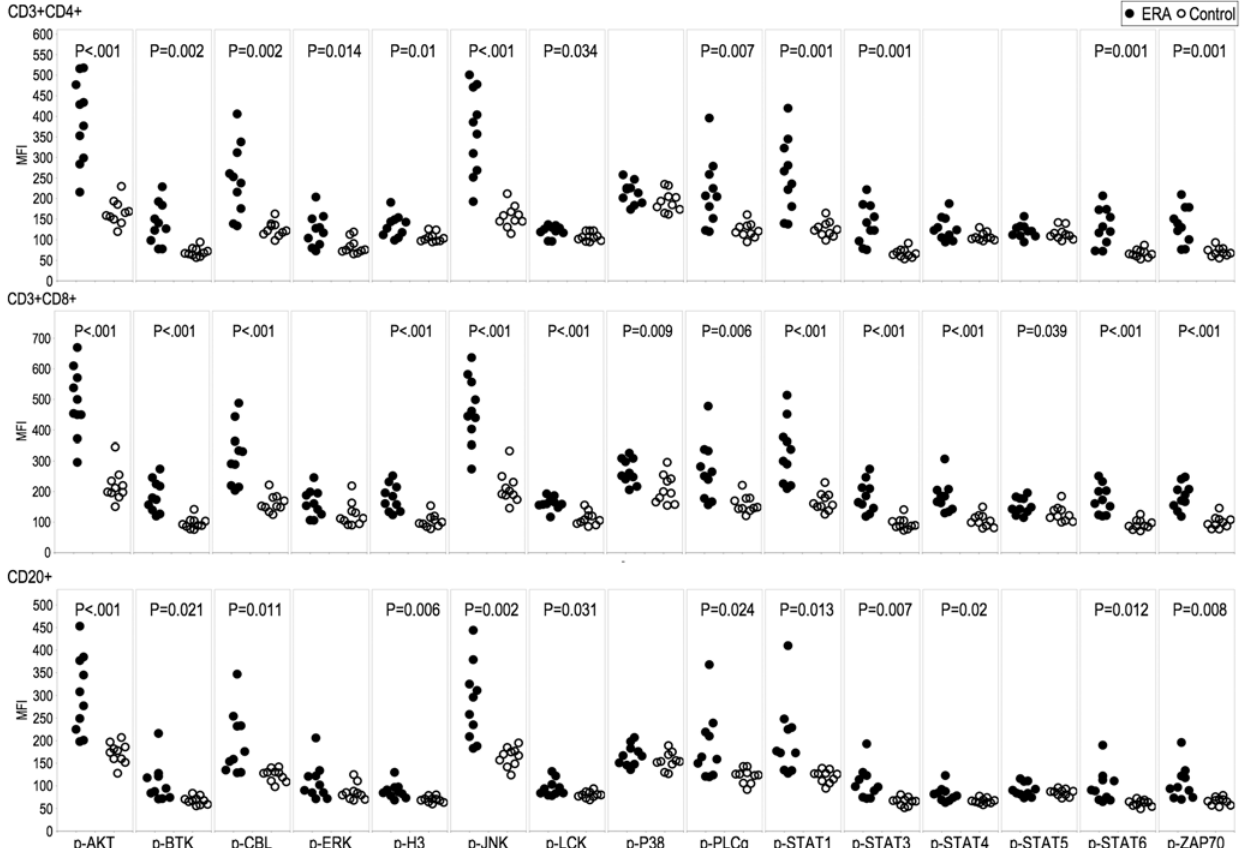
Figure 2. Distinct PBMC subsets in ERA are activated. PBMCs from patients with ERA (n=10, closed circles) and healthy individuals (n=10, open circles) were analyzed by multiparameter phospho-FACS, gating on CD3 + CD4 + , CD3 + CD8 + and CD20 + cell populations, as indicated. Scatterplots of the MFI for15 phospho-specific epitopes are shown. Significant differences in MFI values were calculated by Student’s t test (p , 0.05).